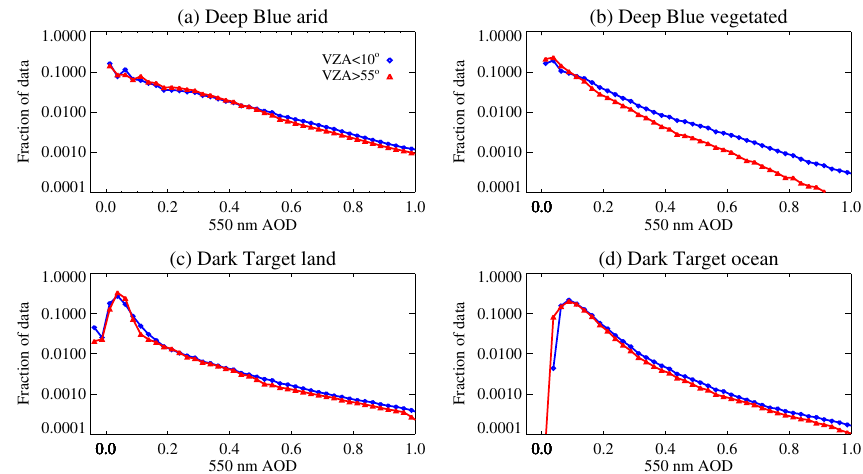
Figure 6. Histograms of retrieved MODIS Aqua AOD at 550nm during the year 2006 retrieved from (a) DB over bright arid surfaces, (b) DB over dark vegetated surfaces, (c) DT over dark vegetated surfaces, and (d) the over-water DT algorithm.